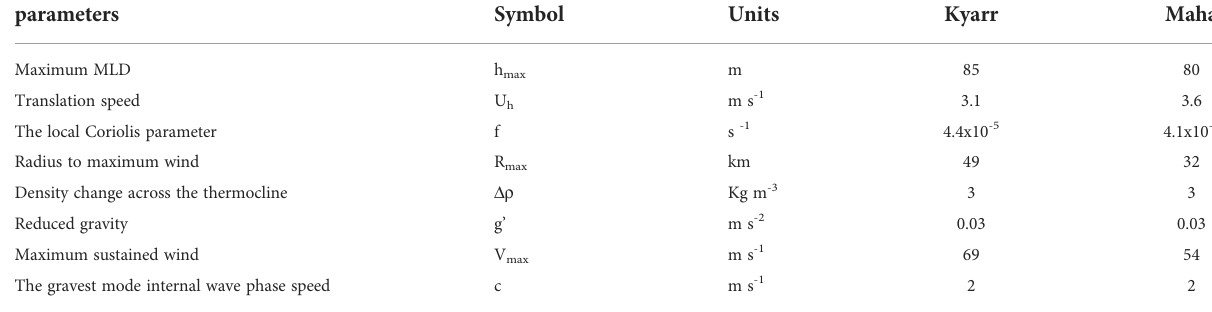
TABLE 3 External